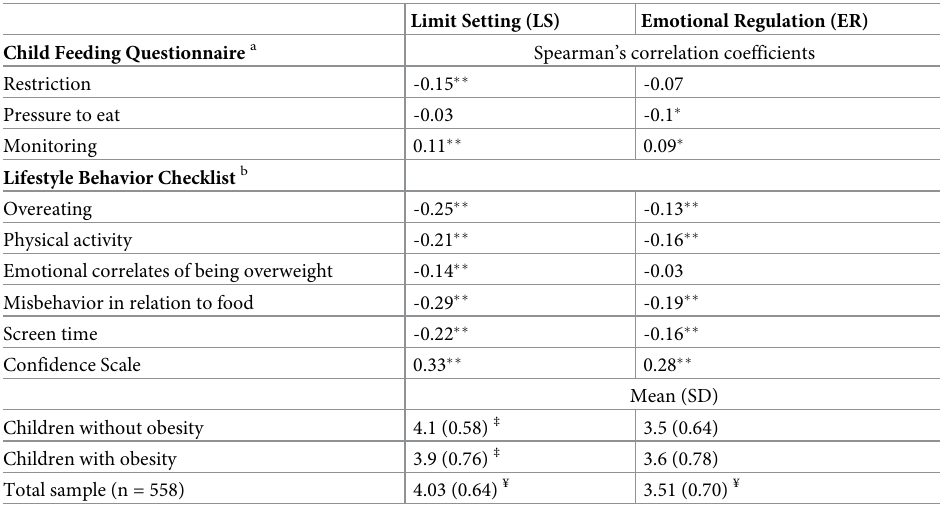
Table 3. Correlations between limit setting/emotional regulation and the CFQ and LBC. Limit Setting